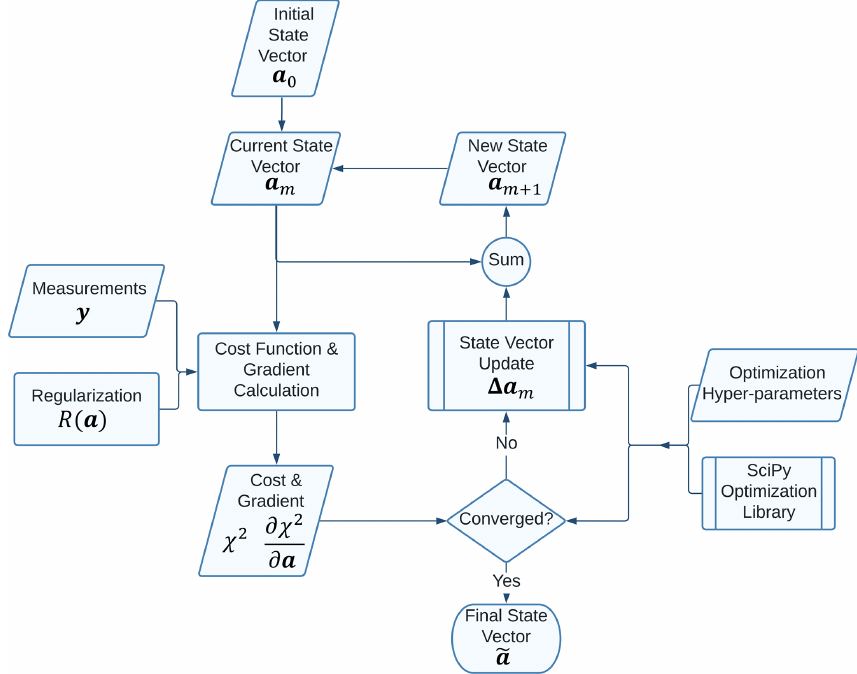
Figure 1. A flowchart depicting the overall iterative retrieval methodology of